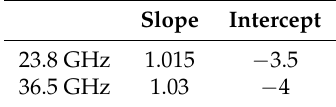
Table 3. Measured-to-simulated brightness temperatures transfer